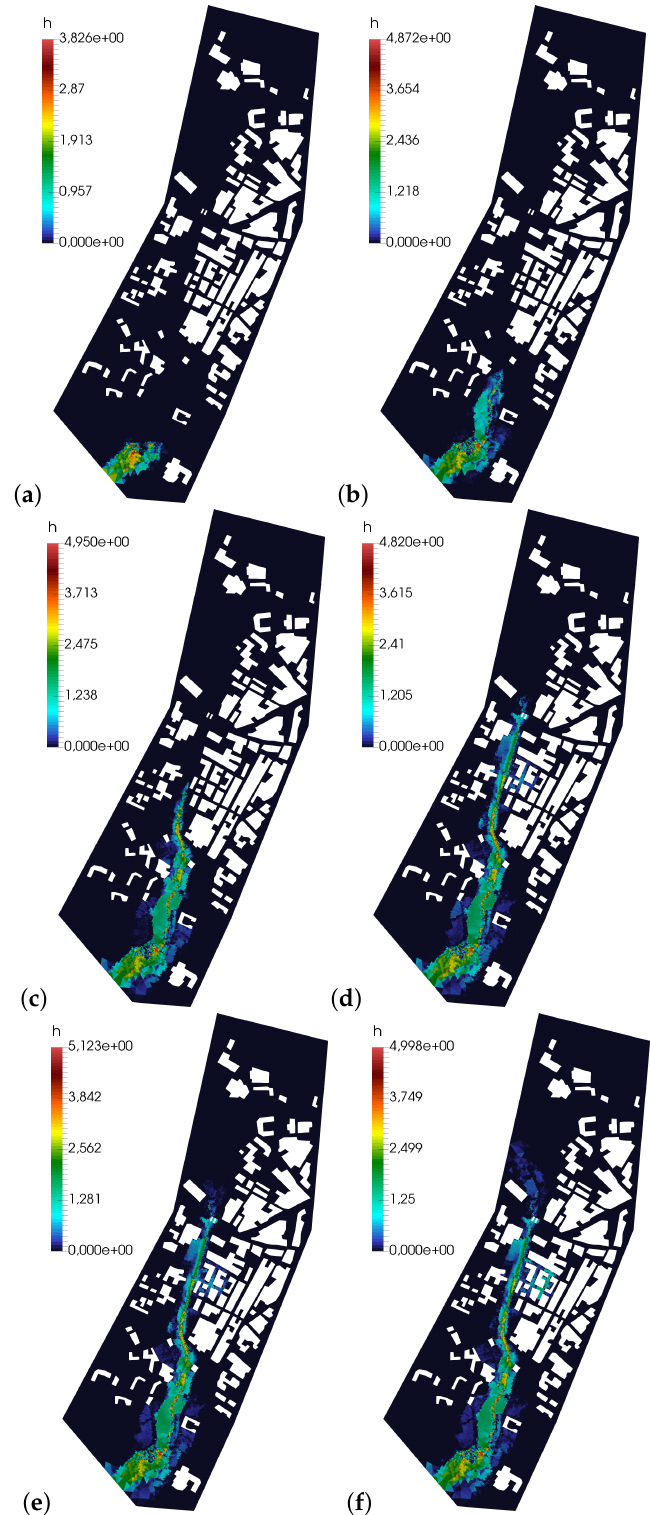
Figure 14. Case 2.2. Water depth values ( h ) in m at t = 60 s ( a ), 150 s ( b ), 300 s ( c ), 750 s ( d ), 1000 s ( e ), and 2500 s ( f